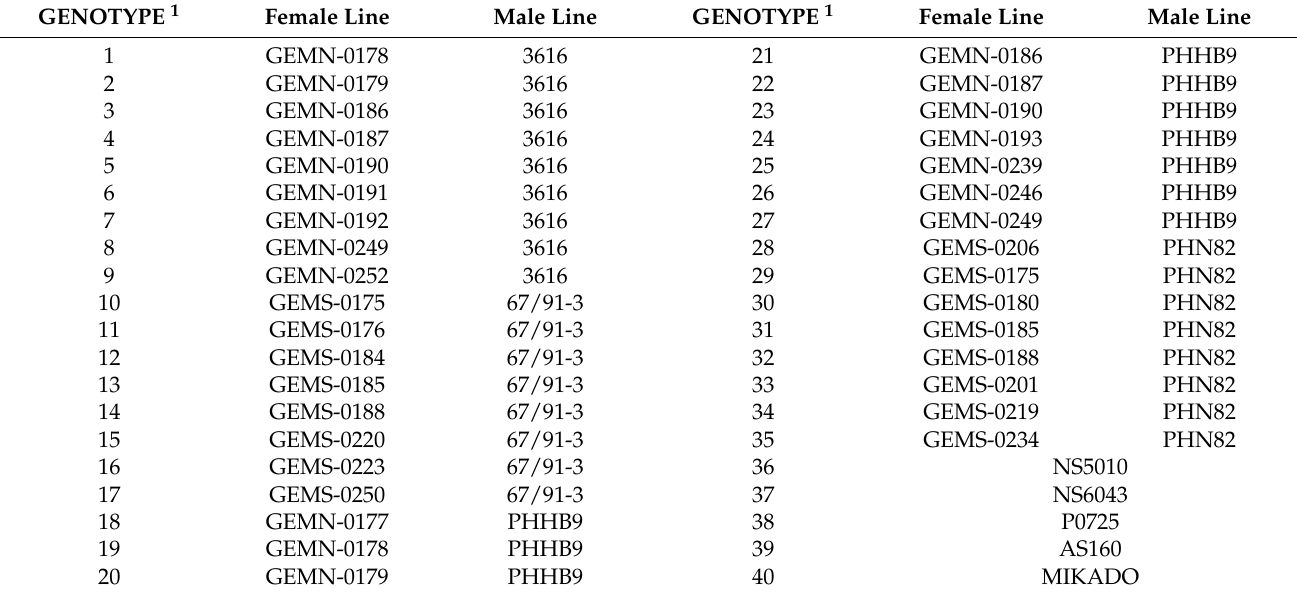
Table 1. Tested hybrids with their parent